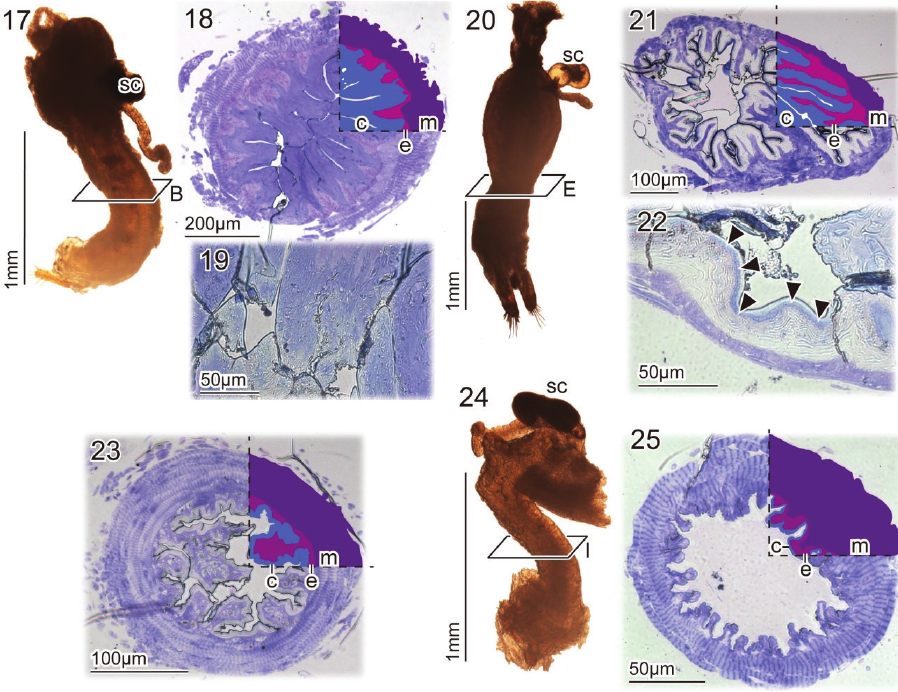
meralis 24–25 Tricholochmaea semifulva species complex. 18, 21, 23, 25 show the cross sections of the lower part of the vagina, where wounds were found in P. maculicollis ; each cuticular, epidermal, and mus- cular layer are partly highlighted in the upper right corner. 19, 22 show enlarged parts of the cuticular, epidermal, and muscular layers; these samples were embedded in glycerine for two days before taking the images. Arrowheads in 22 point to the strip stained with toluidine blue. Abbreviations: c, cuticle; e, epidermis; m, muscles; sc, spermathecal capsule. Table 2. The measurements of the areas of the vagina muscles and epidermal plus cuticular layers. Species N Areas of muscles (µm 2 ) Areas of epidermis and cuticle (µm 2 ) Pyrrhalta maculicollis 2 102545 / 45674 180528 / 84607 Pyrrhalta tibialis 2 12574 / 40076 73012 / 88799 Pyrrhalta humeralis 1 27599 16555 38635 / 13166 23952 /